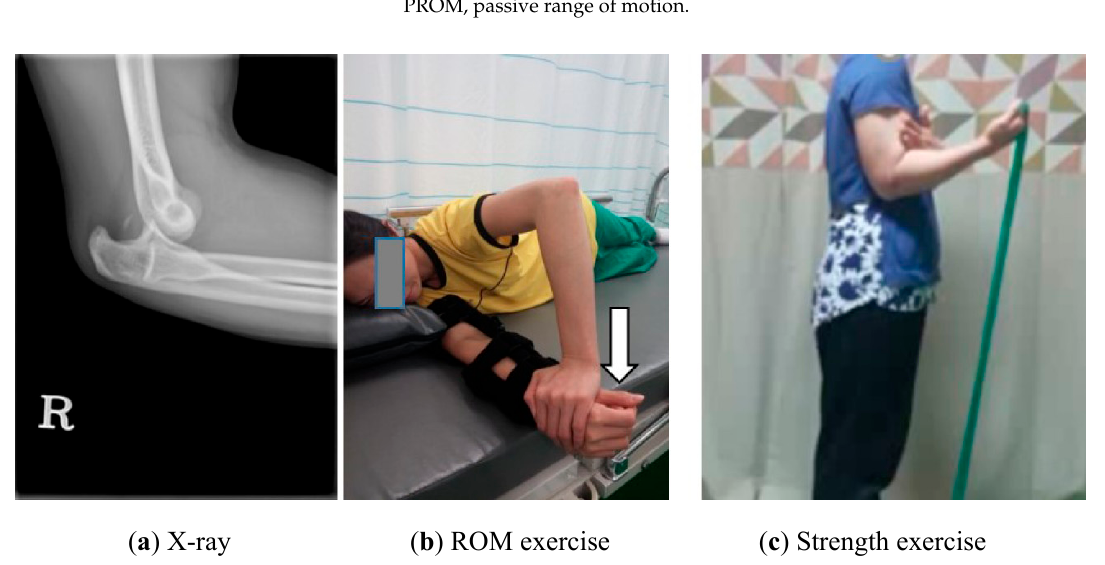
Figure 1. Case A’s X-ray, and range of motion (ROM) and strength exercise.